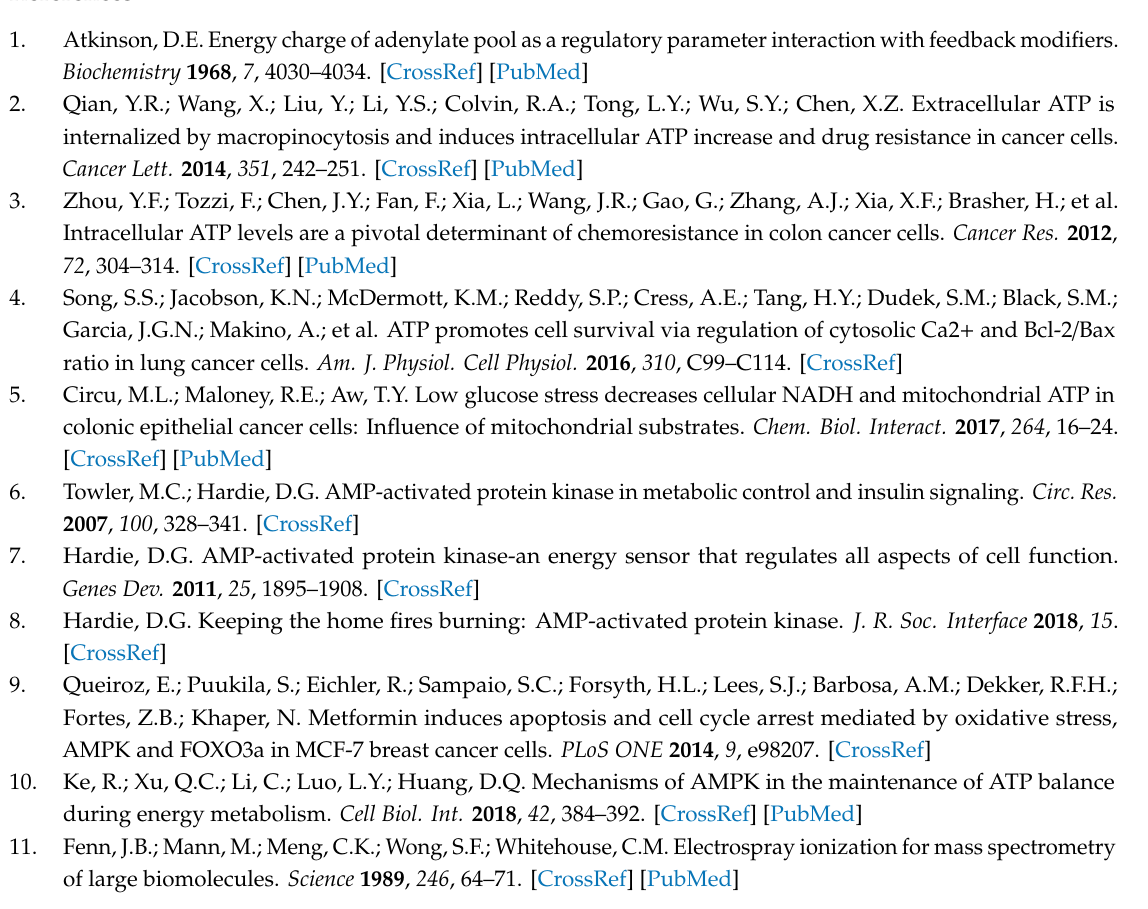
Supplementary Materials: The following are available online, Figure S1: MALDI mass spectra of ATP (1 nmol) in one spot with the matrix of (a) DHB ILs and (b) CHCA ILs in positive reflectron mode, Figure S2: MALDI mass spectra of ATP (1 nmol) in one spot with the matrix of (a) DHB ILs and (b) CHCA ILs in negative reflectron mode, Figure S3: MALDI mass spectra of matrix background for (a) DHB ILs and (b) CHCA ILs in negative reflectron mode, Figure S4: MALDI mass spectra of ADP (1 nmol) in one spot with the matrix of (a) DHB ILs and (b) CHCA ILs in negative reflectron mode, Figure S5: MALDI mass spectra of AMP (1 nmol) in one spot with the matrix of (a) DHB ILs and (b) CHCA ILs in negative reflectron mode, Figure S6: Plot of normalized [ATP-H] − signal distribution of (a) DHB ILs and (b) CHCA ILs in 20 di ff erent positions of one sample spot on the MALDI metal plate, Figure S7: MALDI mass spectra of (a) AMP (1 nmol) (b) ADP (1 nmol) (c) ATP (1 nmol) (d) AMP:ADP:ATP = 1:1:1 (0.33 nmol for each one) with DHBA IL in negative reflectron mode, Figure S8: MALDI mass spectra of (a) AMP (1 nmol) (b) ADP (1 nmol) (c) ATP (1 nmol) (d) AMP:ADP:ATP = 1:1:1 (0.33 nmol for each one) with DHBP IL in negative reflectron mode, Figure S9: MALDI mass spectra of (a) AMP (1 nmol) (b) ADP (1 nmol) (c) ATP (1 nmol) (d) AMP:ADP:ATP = 1:1:1 (0.33 nmol for each one) with CHCA / MI IL in negative reflectron mode, Figure S10: MALDI mass spectra of (a) AMP (1 nmol) (b) ADP (1 nmol) (c) ATP (1 nmol) (d) AMP:ADP:ATP = 1:1:1 (0.33 nmol for each one) with CHCA / TPA IL in negative reflectron mode, Figure S11: Quantitative comparison between theoretical and experimental ratios of AMP, ADP, and ATP, Table S1: Melting points of conventional matrices (DHB and CHCA) and IL matrices measured by the Mel-Temp II Capillary Melting Point Apparatus (Laboratory Devices Inc.,